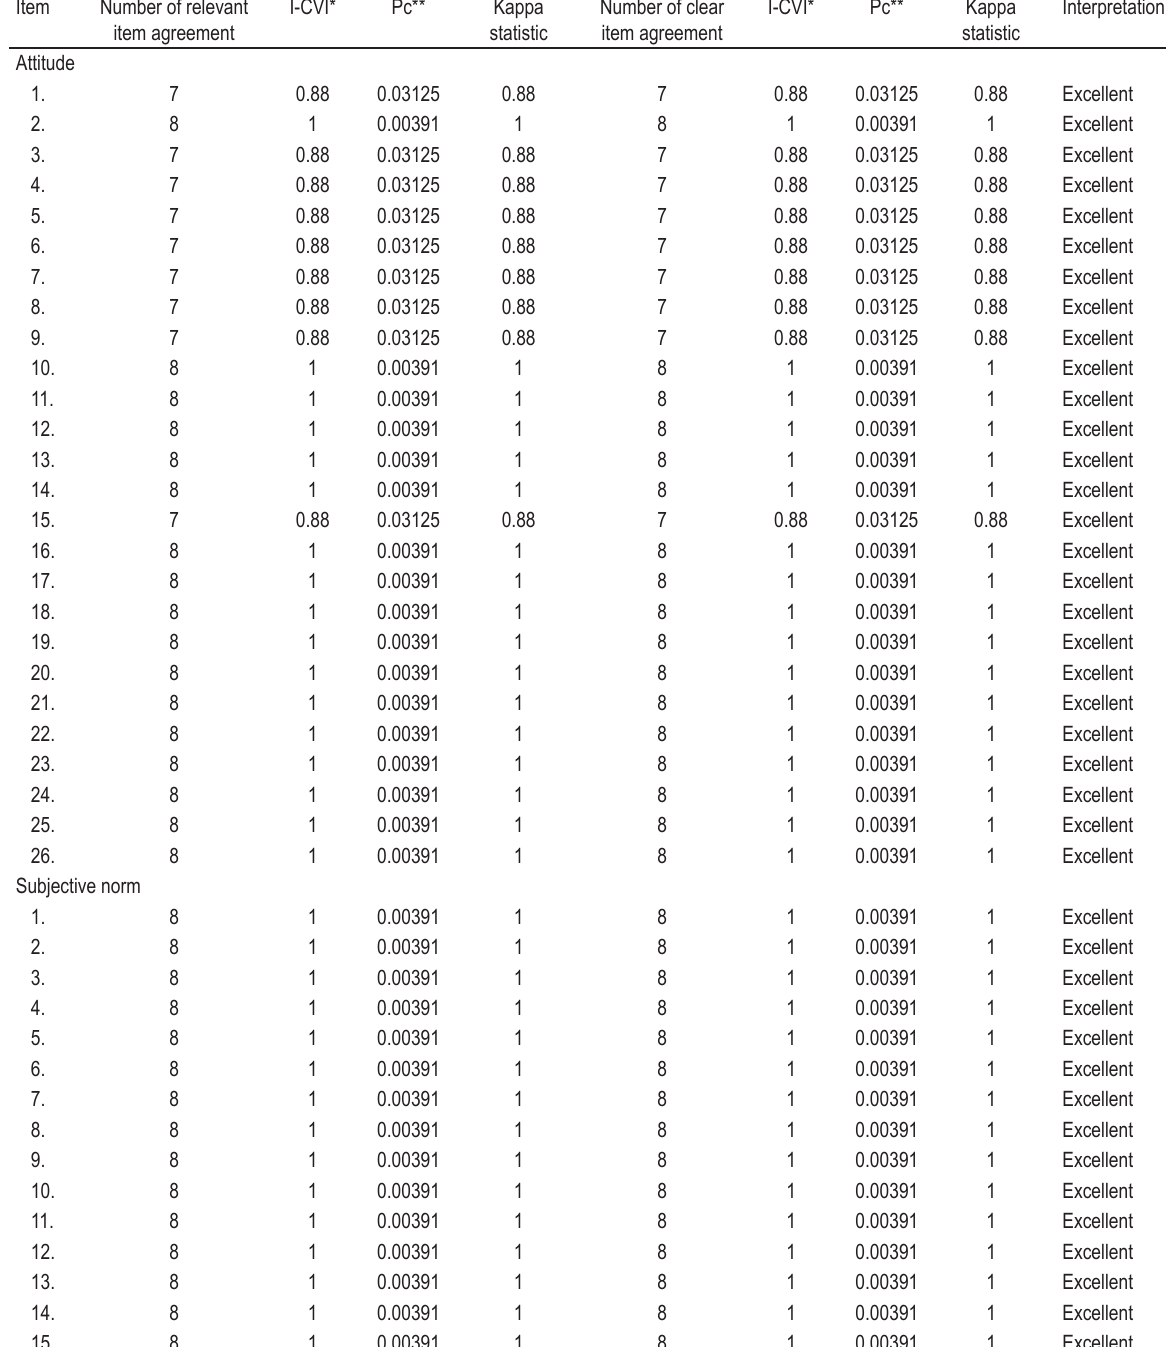
TABLE 2. The I‑CVI dan kappa statistics scores in the dimension of attitude, subjective norms, behavioral control, and intention on the adolescents’ balanced dietary